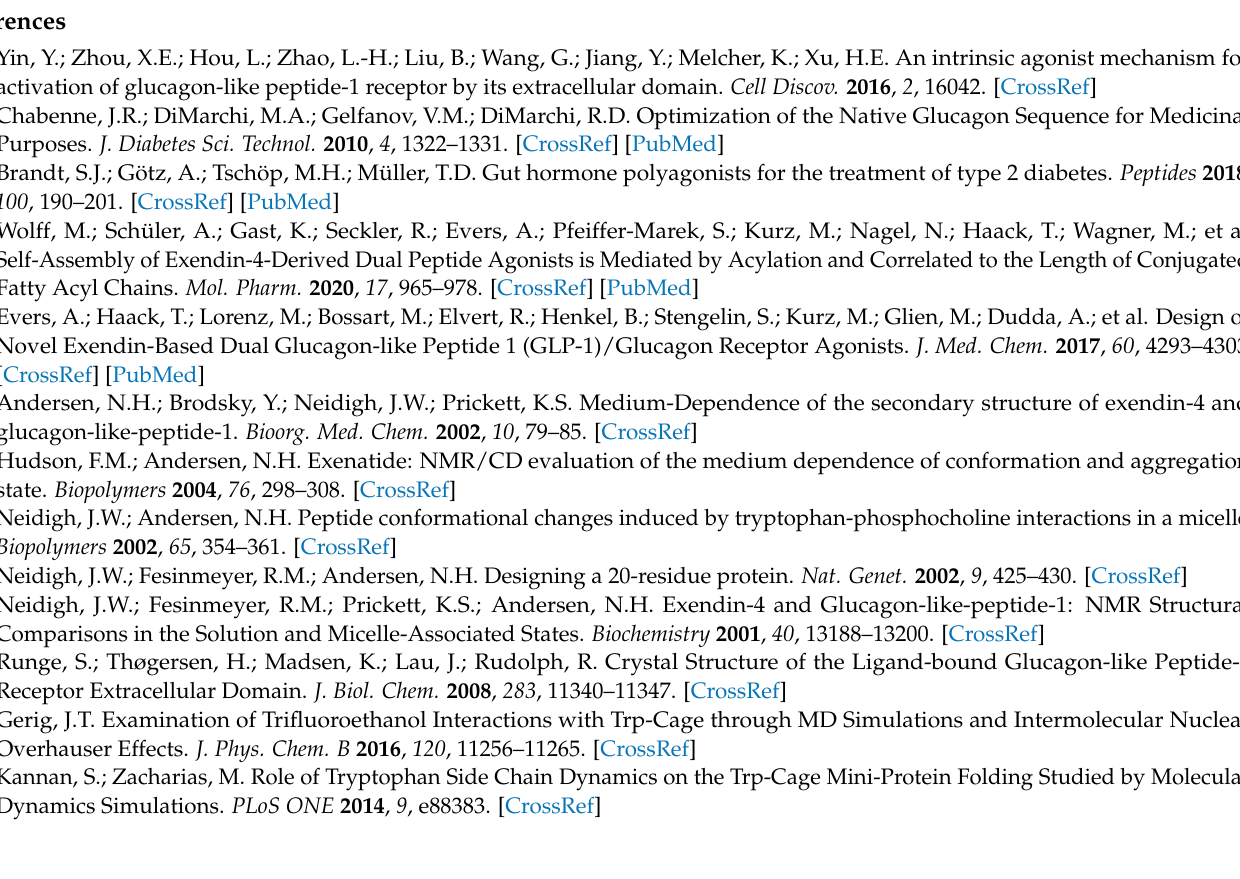
Figure S2: Titration of exendin-4 in PBS, pH 7.4 with TFE, Figure S3: Far-UV CD spectra of exendin-4 and Dual-Cex and the respective F22R mutants of both peptides, Figure S4: Temperature dependence of θ 222 from far UV CD spectra for exendin-4 at 0.4 mM at pH 7.4, Figure S5: Compactness